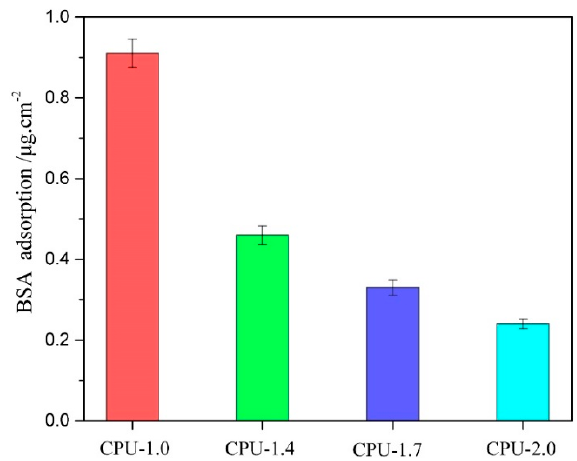
Figure 10. Amount of BSA adsorbed on the surface of CPU films with different COS content at 37 ± 0.5 °C.